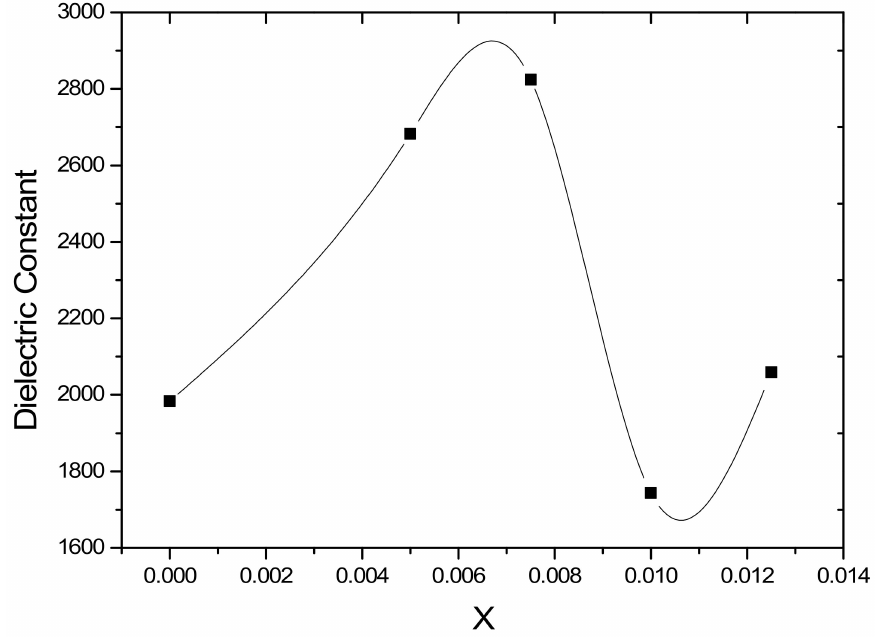
Figure 6. Dielectric constant with Sm